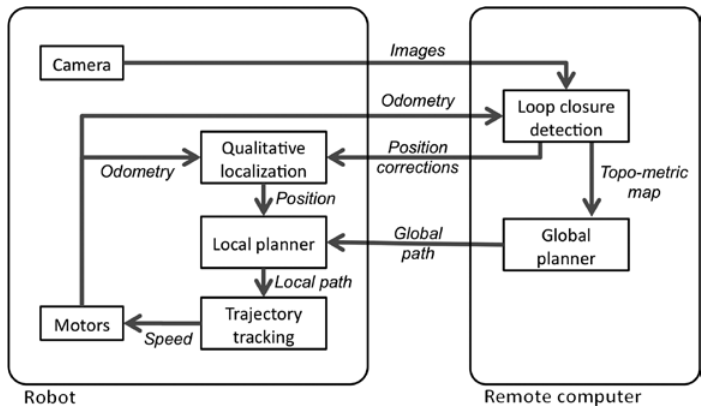
Figure 9. Simplified Diagram of Urbi Components Used by the Path-Following